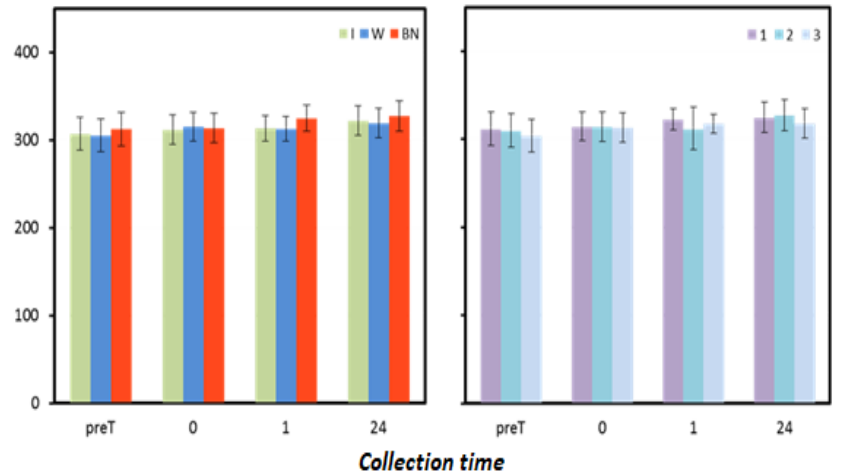
Figure 4. Oxidative status. Mean values estimated by the method of least squares(µmoL·L −1 ) (I — isotonic; W — water; BN — none) (immediately preT, postT, 1, 24, and 48 h) taken in 12 men in three consecutive tests (1, 2, 3). Table 6. Results of analysis of variance for pro-oxidant/antioxidant status and oxidative status meas- ured before the test (preT) and 0, 1, and 24 h after the exercise test: significance of (P) and F-statistic along with the number of degrees of freedom (DFi — in the numerator; DFm — in the denominator) for the fixed effects (hydration strategy, test sequence, and their interaction).